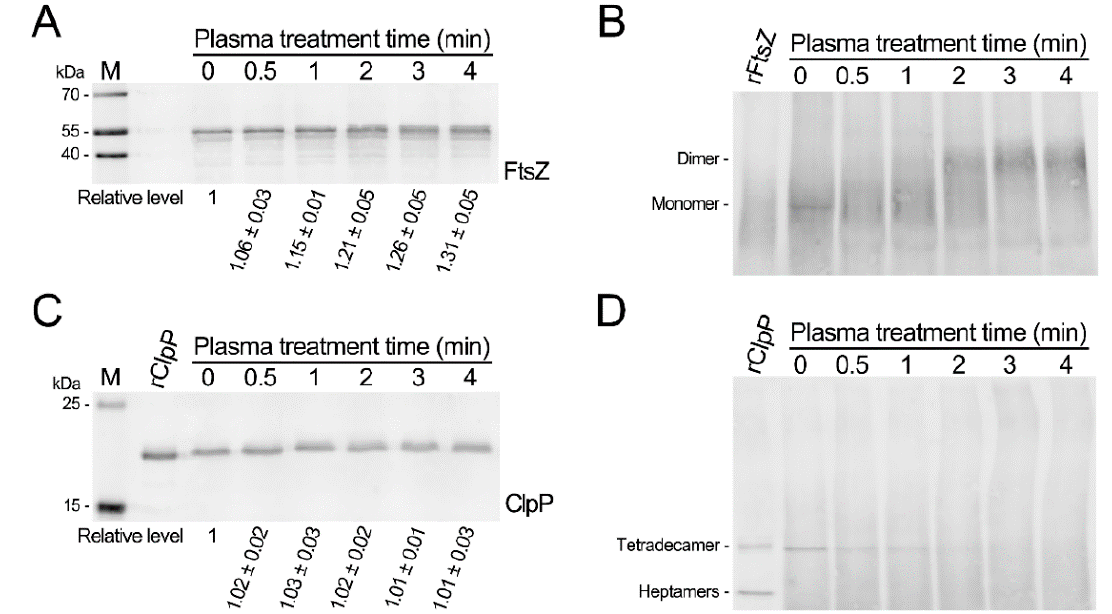
Figure 3. Polymerization of SaFtsZ and SaClpP in S. aureus biofilms induced by plasma treatment. ( A ) Immunoblotting of SaFtsZ under denaturing conditions. ( B ) Immunoblotting of SaFtsZ under nondenaturing conditions. ( C ) Immunoblotting of SaClpP under denaturing conditions. ( D ) Immunoblotting of SaClpP under nondenaturing conditions. The plasma-treated and untreated biofilms were dispersed and lysed, and then the soluble proteins were extracted and subjected to SDS-PAGE or blue native PAGE. The SaFtsZ and SaClpP proteins were detected by immunoblotting using anti-SaFtsZ and anti-SaClpP antibodies, respectively.